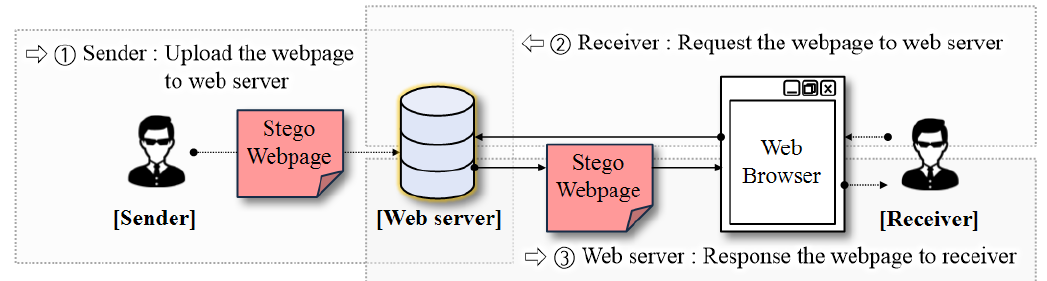
Figure 5. Covert communication model using webpages’ steganography techniques.